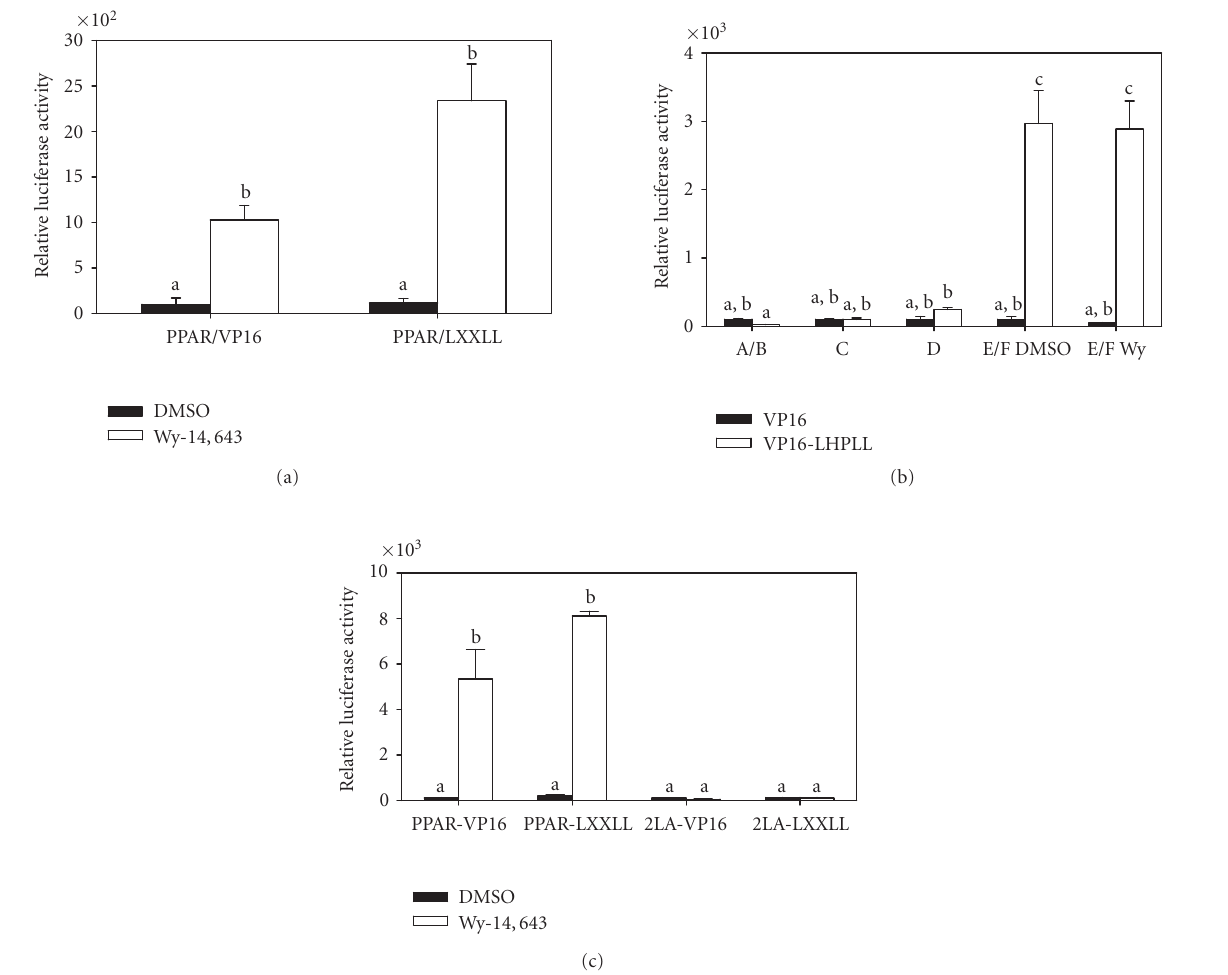
Figure 6: Intramolecular interaction of PPAR α LXXLL motif. Panel (a): 456 LHPLL of wild type PPAR α was fused to the VP16AD and used in a mammalian-2-hybrid assay with pM/PPAR α . COS-1 cells were transfected and treated with 50 μ M Wy-14,643 for 6 hours. Luciferase activity was measured and corrected for transfection e ffi ciency and extraction yield ( n = 3). Bars are standardized to the pVP16 DMSO control bar (100%). Bars with di ff erent letters above are significantly di ff erent from each other (Tukey’s multicomparison test, P < . 05). Panel (b): COS-1 cells were transiently transfected with GAL4DBD fusions of PPAR α or each domain with VP16AD- 456 LHPLL or empty vector control. Luciferase values were measured and corrected for transfection e ffi ciency and extraction yield ( n = 3). Bars are standardized to untreated VP16 value for each domain individually (100%). Bars with di ff erent letters above are significantly di ff erent from each other (Tukey’s multicomparison test, P < 0 . 05). Panel (c): COS-1 cells were transiently transfected with PPAR α wild type and 2LA mutant and were fused to the GAL4DBD and transfected with VP16AD fused to 456 LHPLL or empty vector. Cells were treated with 50 μ M Wy-14,643 for 6 hours. Luciferase activity was measured and corrected for transfection e ffi ciency and extraction yield ( n = 3). Relative luciferase levels were corrected to wild type VP16 untreated bar (100%). Bars are graphed on a log scale along the y -axis to facilitate viewing. Bars with di ff erent letters above are significantly di ff erent from each other (Tukey’s multicomparison test, P < . 05), representative of 2 independent